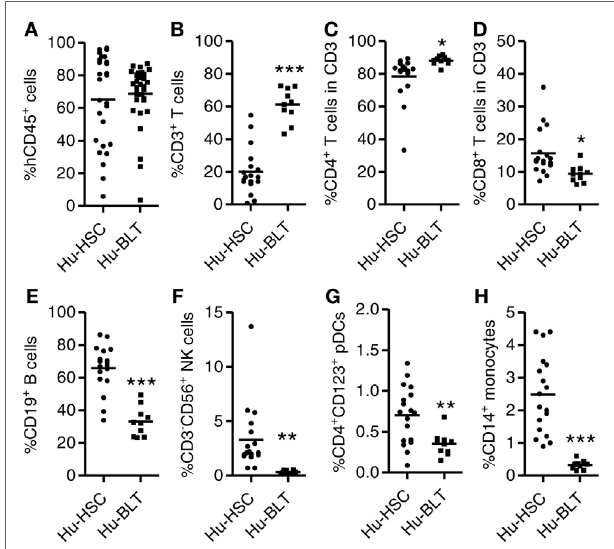
FigUre 1 | Comparison of human immune cell reconstitution in peripheral blood of NRG-hu HSC and NRG-hu Thy/HSC mice. NRG-hu HSC and NRG-hu Thy/HSC mice were generated as indicated in Section “Materials and Methods.” (a) Summarized data show percentage of human leukocytes (hCD45 + ) in total peripheral blood leukocytes 12 weeks after reconstitution. Shown are combined data from two cohorts of NRG-hu HSC mice ( n = 27) and NRG-hu Thy/HSC mice ( n = 35) reconstituted with HSCs ± thymus from the same human donor. (B–h) Summarized data show percentage of human T cells (CD3 + ), B cells (CD19 + ), NK cells (CD3 − CD56 + ), plasmacytoid dendritic cells (pDCs) (CD3 − CD19 − HLA-DR + CD4 + CD123 + ), and monocytes (CD3 − CD19 − HLA-DR + CD14 + ) in human CD45 + cells (B,e–h) and percentage of human CD4 T and CD8 T cells in human CD3 T cells (c,D) . Shown are representative data (B–h) from n = 18 (NRG-hu HSC) and n = 10 (NRG-hu Thy/HSC) hu-mice reconstituted with HSCs ± thymus from same donor. Each dot represents one individual mouse; bars indicate mean (* P < 0.05, ** P < 0.01, and *** P < 0.001, by unpaired, two-tailed Student’s t